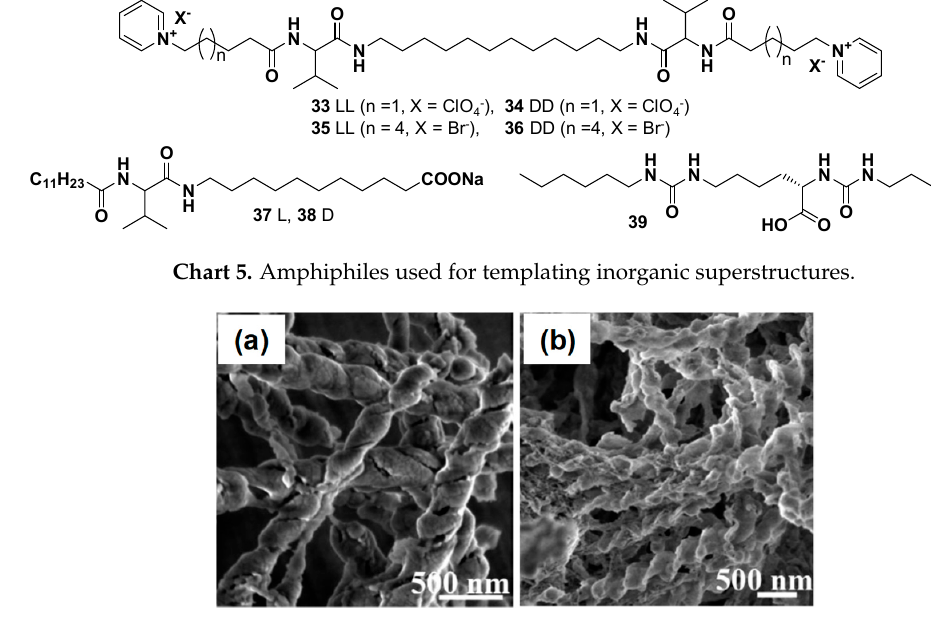
Figure 9. FE-SEM images of the ( a ) right- and ( b ) left-handed helical ZrO 2 nanotubes and double coiled Figure 9. FE ‐ SEM images of the ( a ) right ‐ and ( b ) left ‐ handed helical ZrO 2 nanotubes and double Figure 9. FE ‐ SEM images of the ( a ) right ‐ and ( b ) left ‐ handed helical ZrO 2 nanotubes and double nanoribbons after being calcined at 700 ◦ C for 3.0 h. Reproduced with permission from Reference [83]. coiled nanoribbons after being calcined at 700 °C for 3.0 h. Reproduced with permission from coiled nanoribbons after being calcined at 700 °C for 3.0 h. Reproduced with permission from Figure 9. FE ‐ SEM images of the ( a ) right ‐ and ( b ) left ‐ handed helical ZrO 2 nanotubes and double Reference [83]. Reference [83]. coiled nanoribbons after being calcined at 700 °C for 3.0 h. Reproduced with permission from Reference [83].